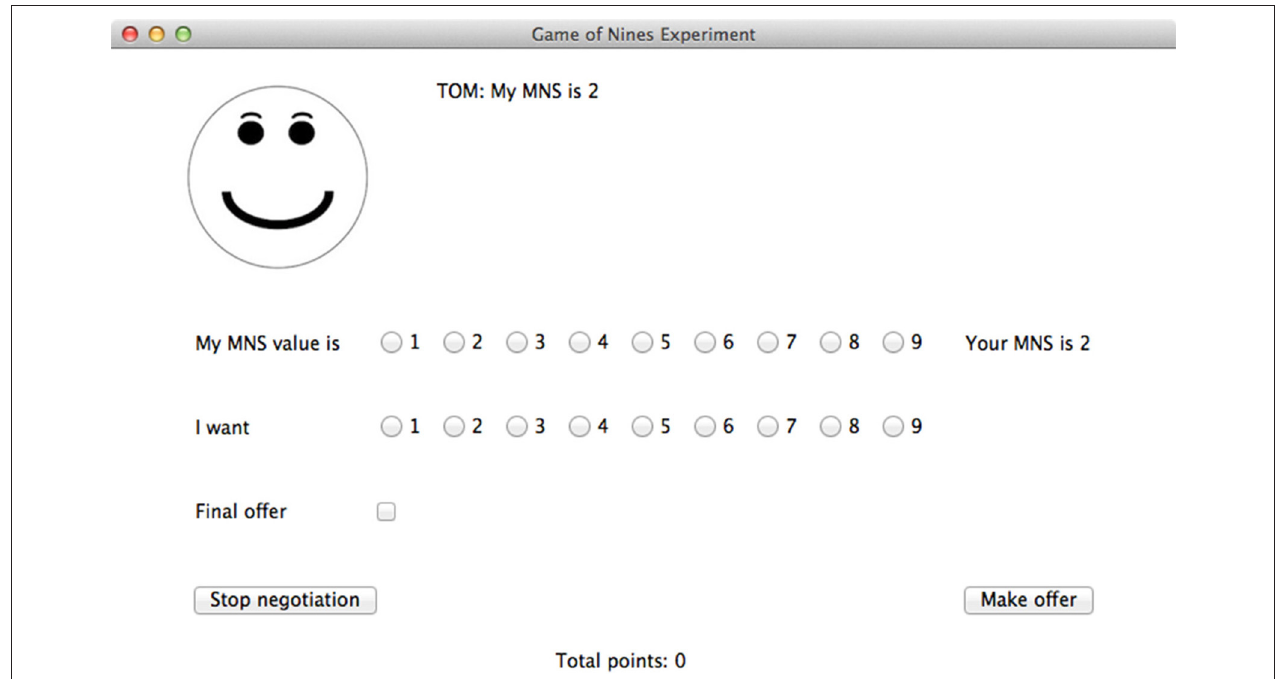
FIGURE 1 | The user interface for the Game of Nines